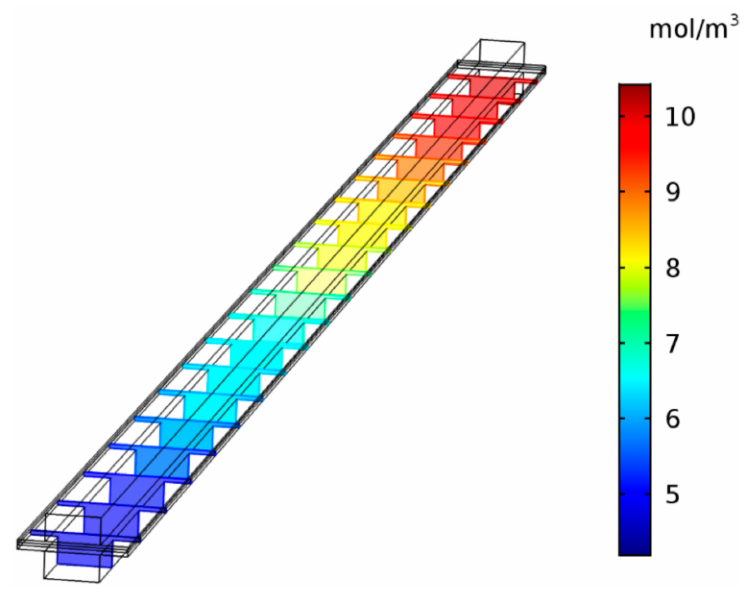
Figure 7. Distribution of hydrogen mole fraction along the anode